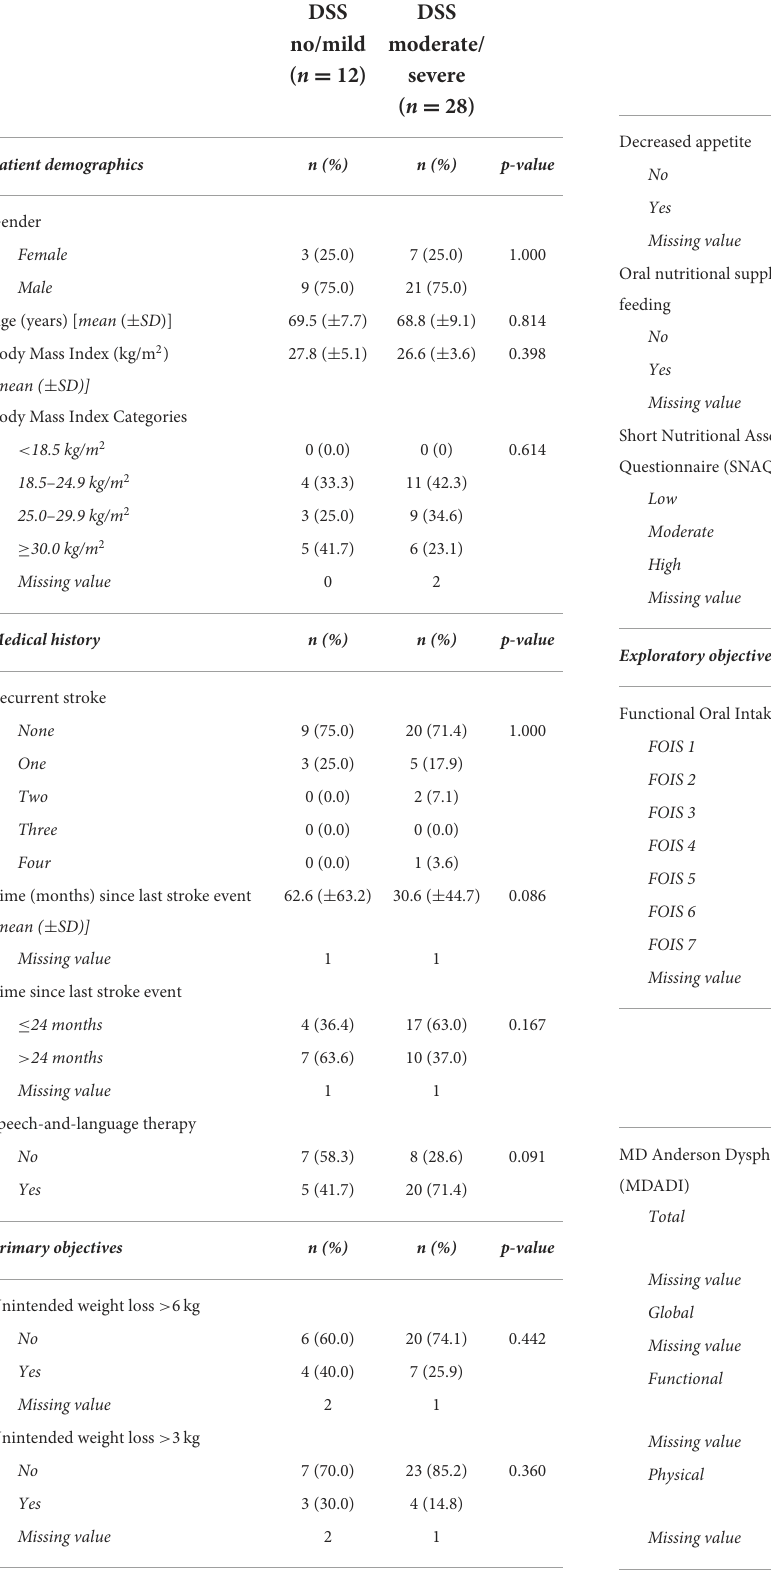
TABLE 2 Patient characteristics in patients with no/mild OD severity vs. moderate or severe OD according to the DSS ( n =